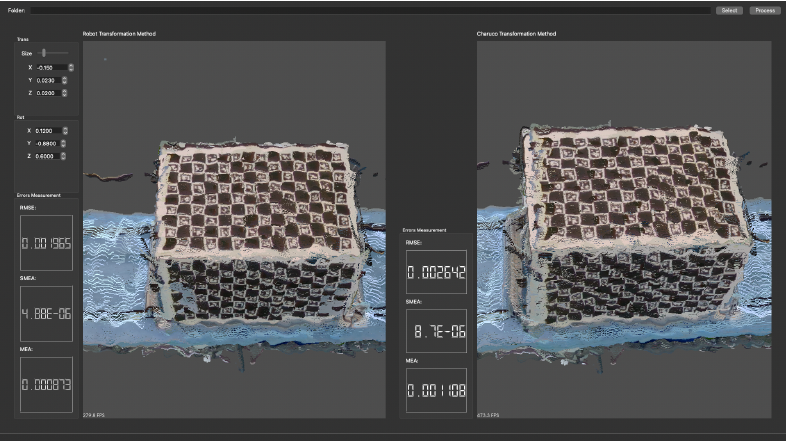
Figure 16. GUI showing the resulting 3D reconstruction using unfiltered data.